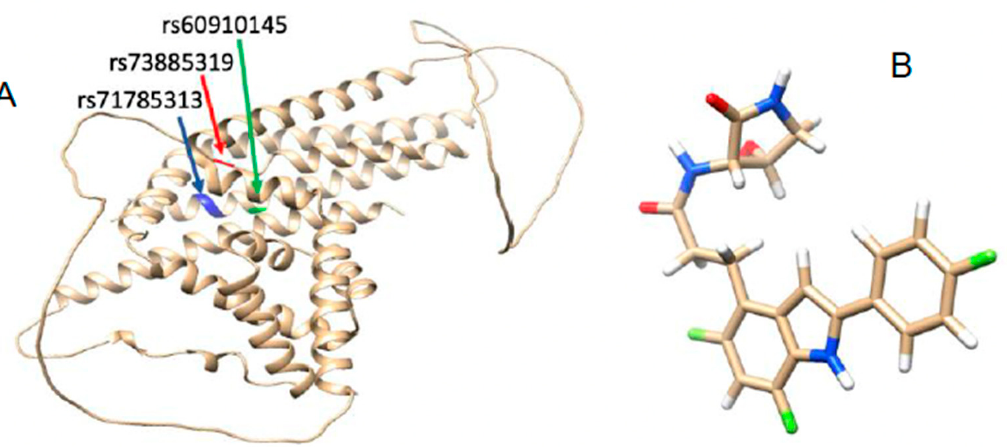
Figure 1. The 3D structure of APOL1 protein highlighting the point of mutation ( A ) and 3D structure of potential APOL1 inhibitor ( B ). For the G1 mutations, SNPs rs60910145 and rs73885319 correspond to I384M and S342G respectively, while, for G2, SNP rs1785313 corresponds to N388del: Y389del.